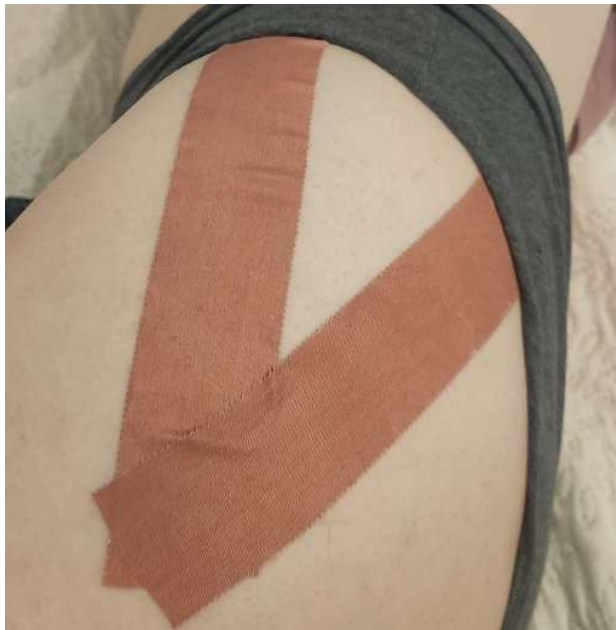
Figure 3. The method of rigid tape application used.